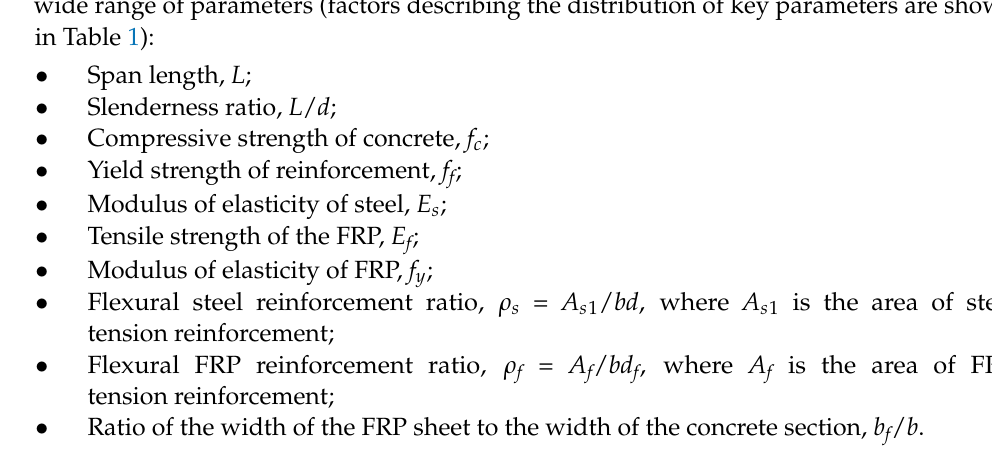
Table 1. Parameters of specimens selected for